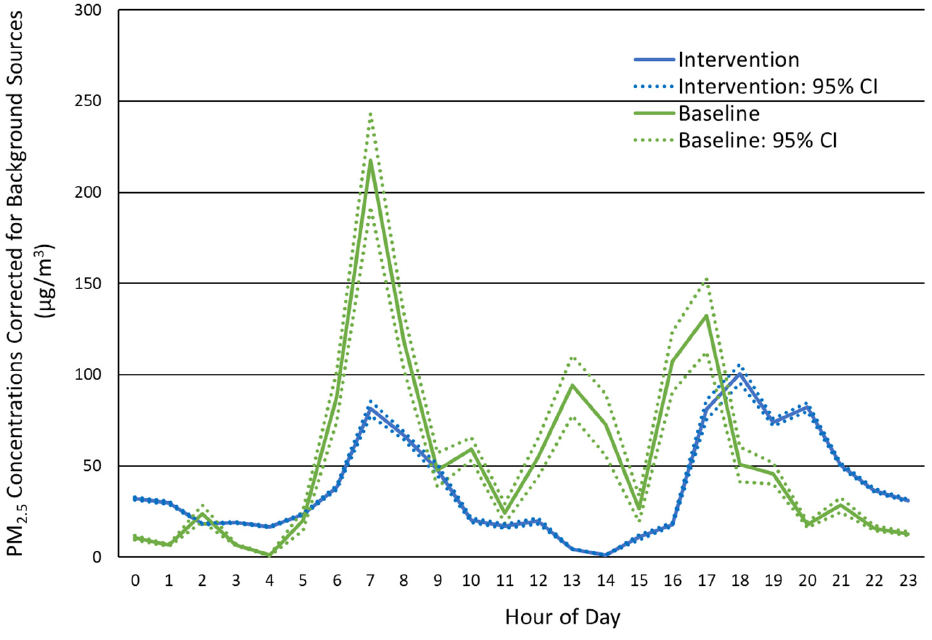
Figure 3. Baseline and intervention phase hourly PM 2.5 concentrations corrected for background sources to emphasize the contribution of cookstove emissions. Mean and 95% confidence intervals are shown.